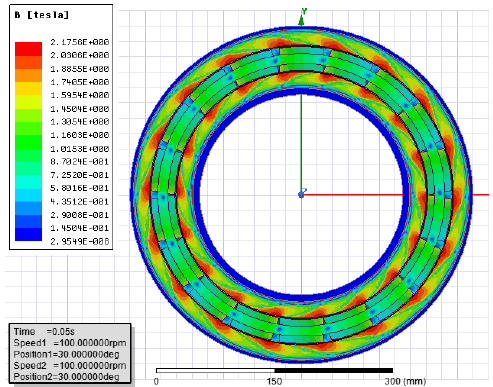
Figure 13. Magnetic density nephogram of the rotor drum at 100 rpm.